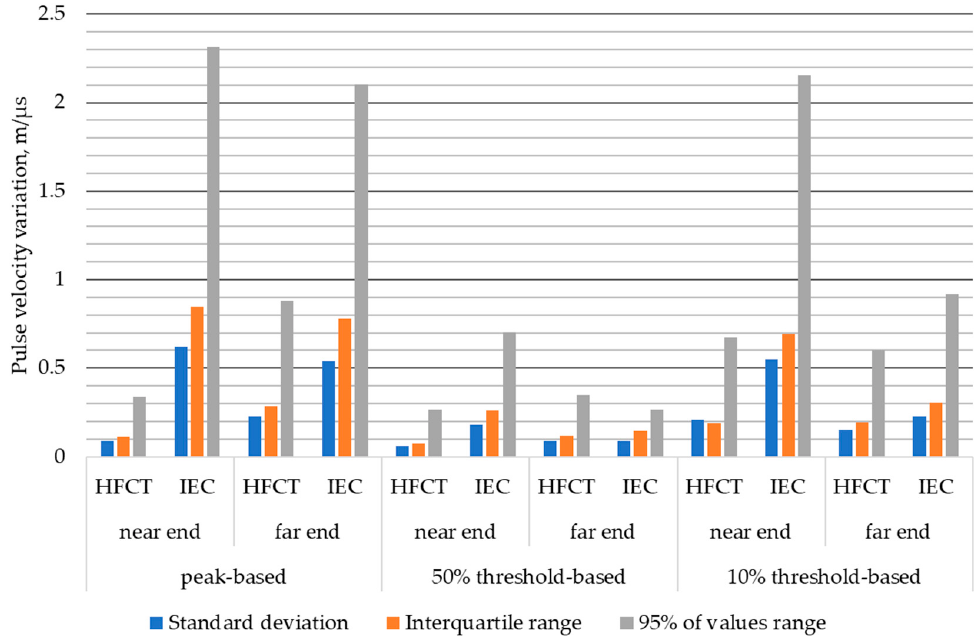
Figure 12. Comparison of pulse velocity variation metrics determined using different reference points for velocity measurement, expressed in terms of SD, interquartile range, and 95% of values range, based on 1000 velocity measurements performed for each case.